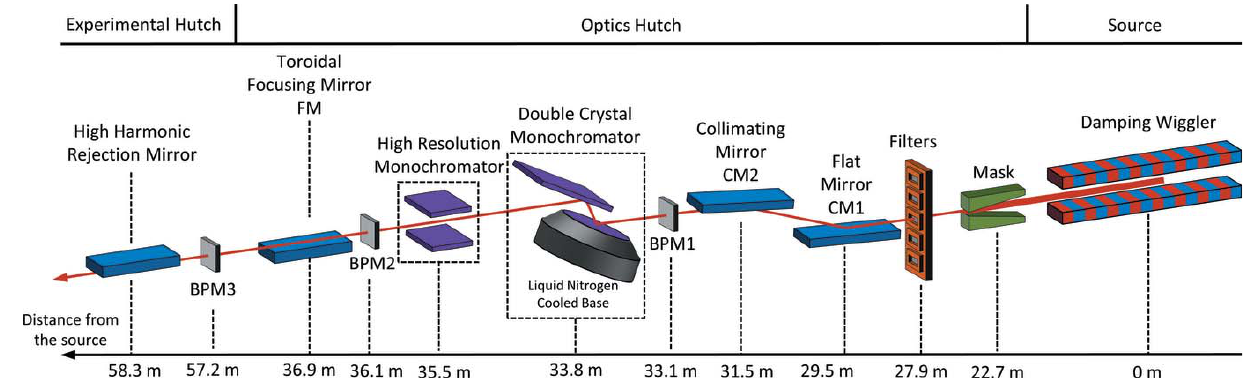
Figure 1 Optical scheme of the Inner Shell Spectroscopy beamline at NSLS-II. BPM denotes beam position